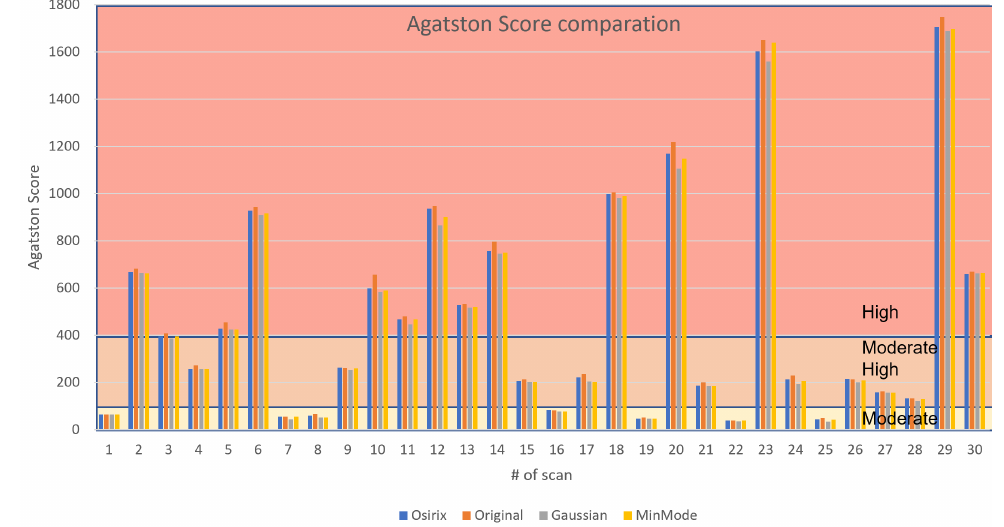
Figure 6. Total CS and risk category classification of the performed